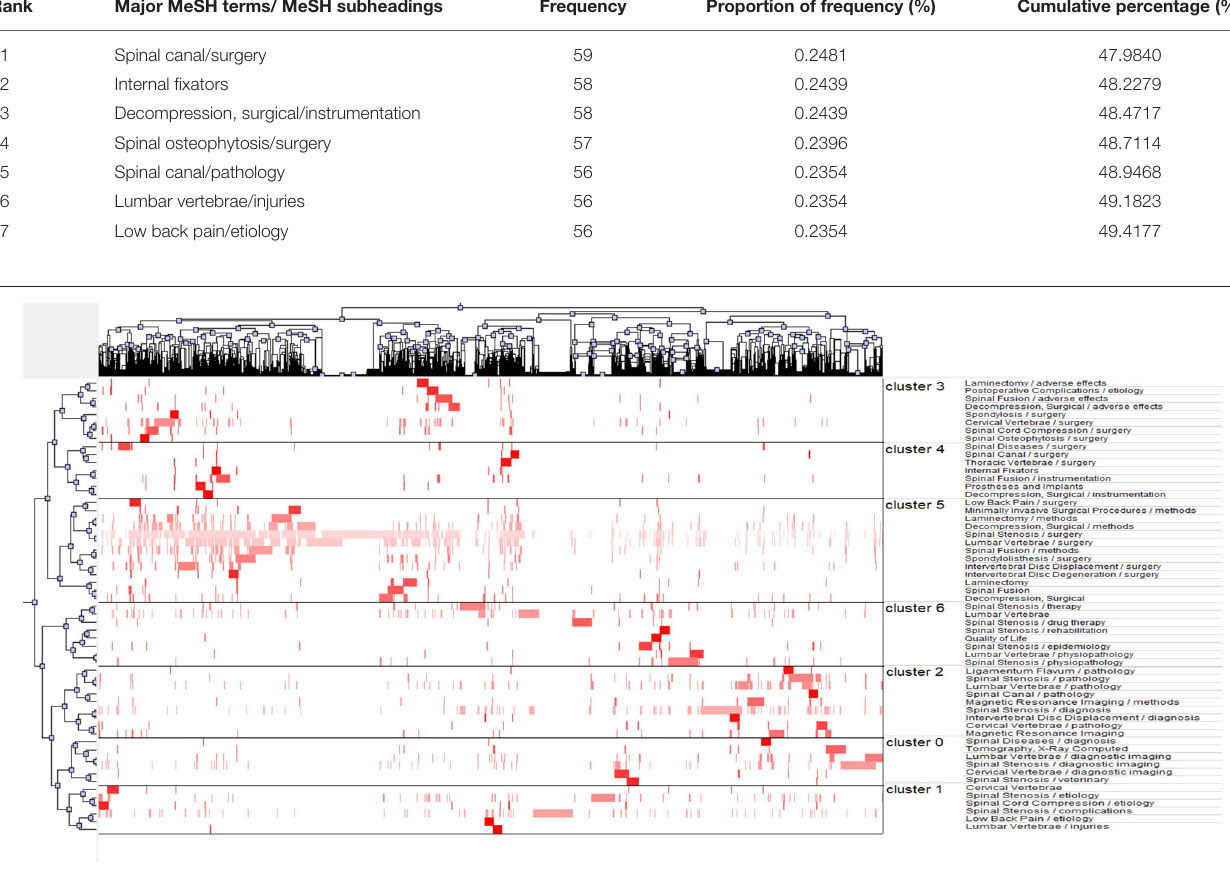
FIGURE 8 | Matrix visualization of biclustering of high-frequency major MeSH terms and PMIDs of articles on spinal stenosis. TABLE 6 | High-frequency major MeSH a terms-source articles matrix (localized).